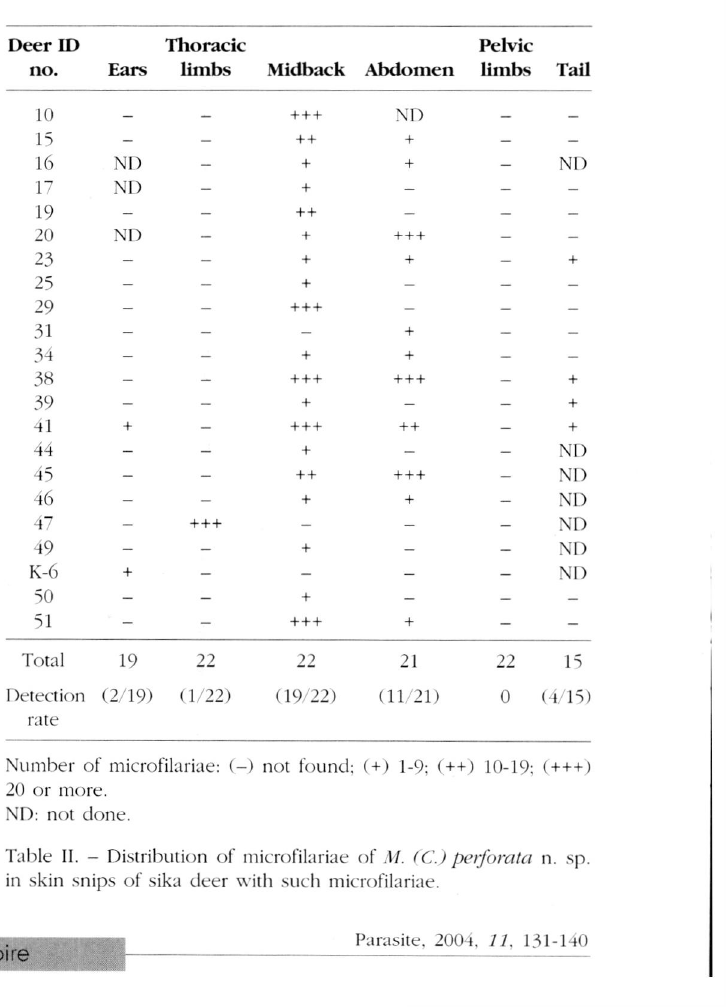
Table II. - Distribution of microfilariae of M. (C.)